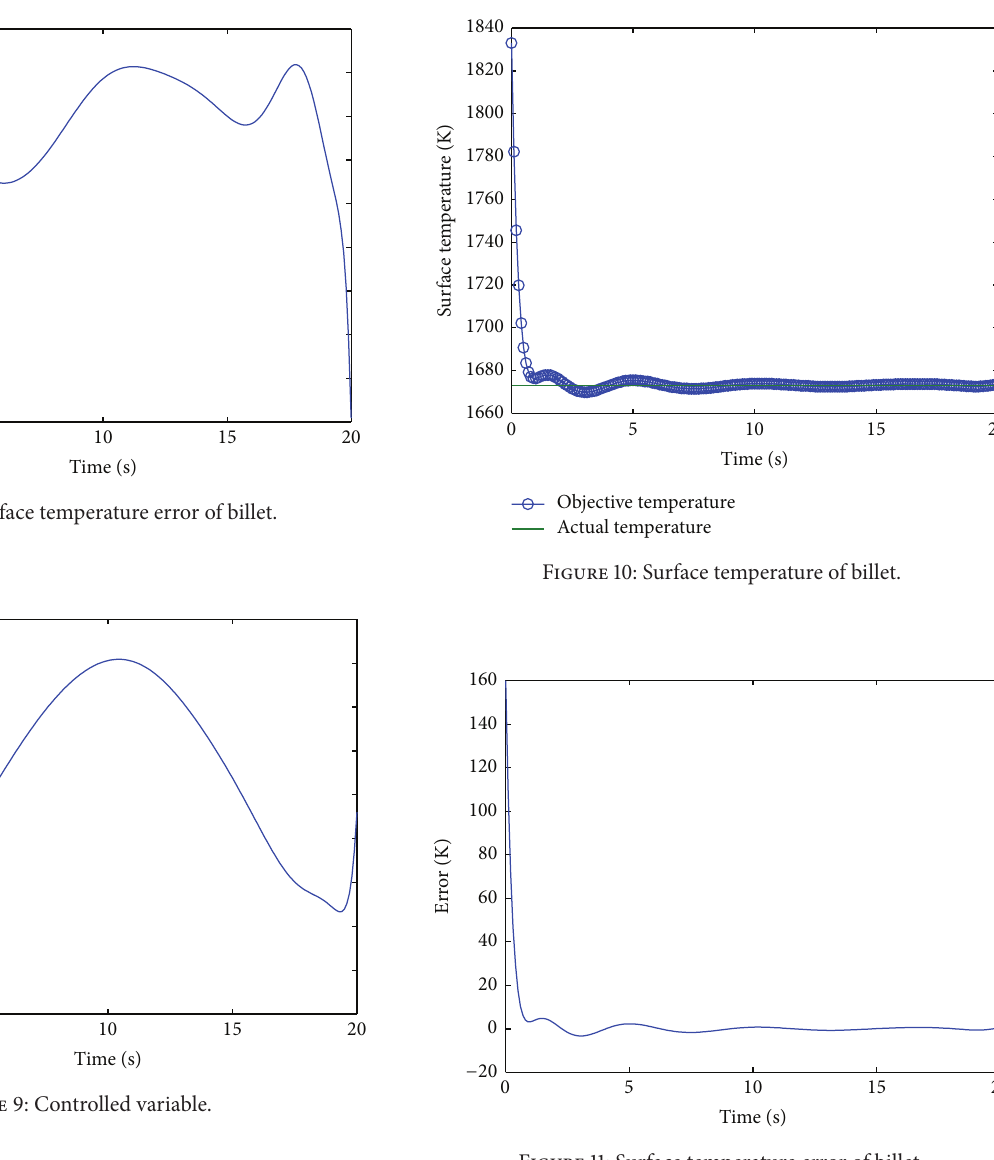
Figure 11: Surface temperature error of